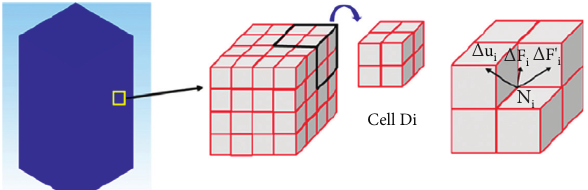
Figure 5: Numerical model and three-dimensional domain to be solved.